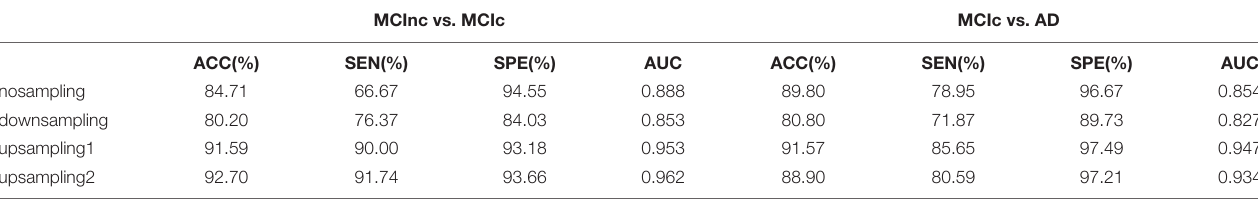
TABLE 5 | Classification performance of resample data based on RSFS algorithm and SVM classifier using the top 10 features. MCInc vs. MCIc MCIc vs.